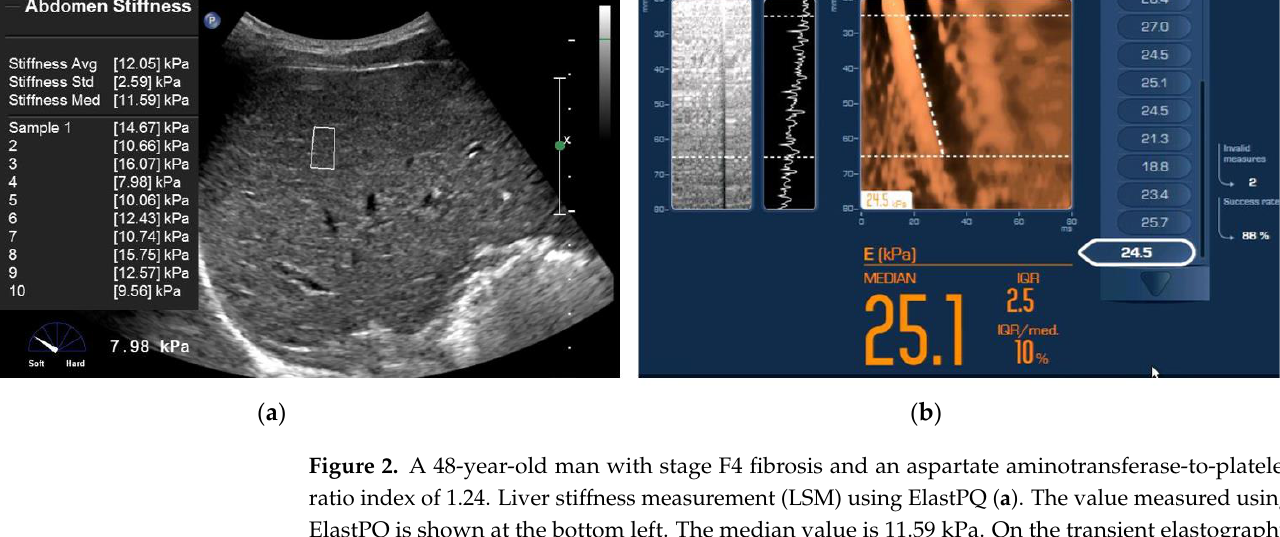
Table 1. Patient demographics and clinical features.